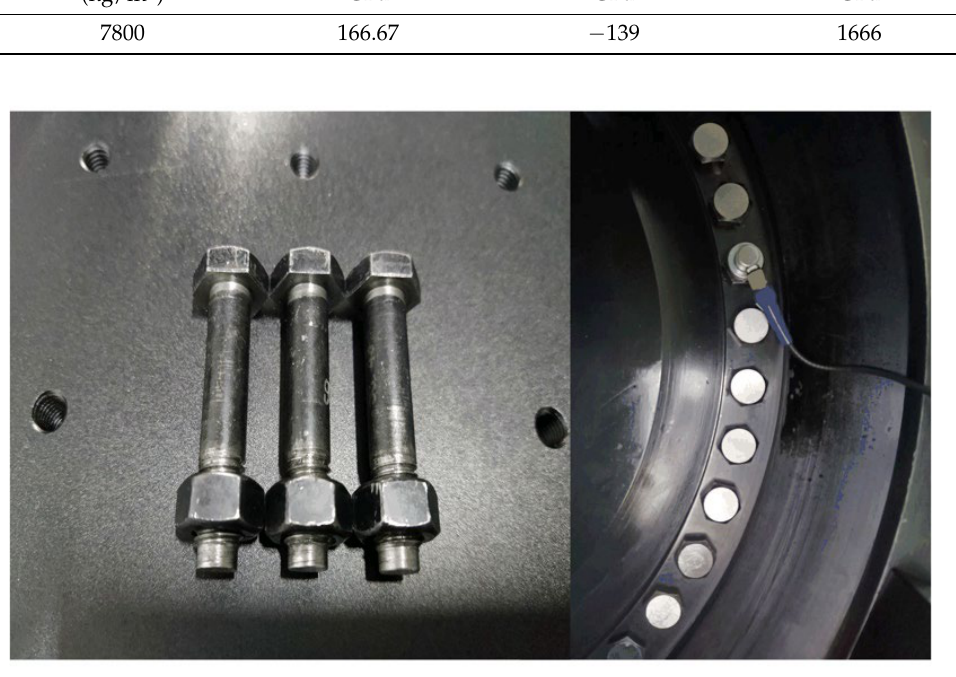
Figure 5. The polished surface of the bolt specimens.